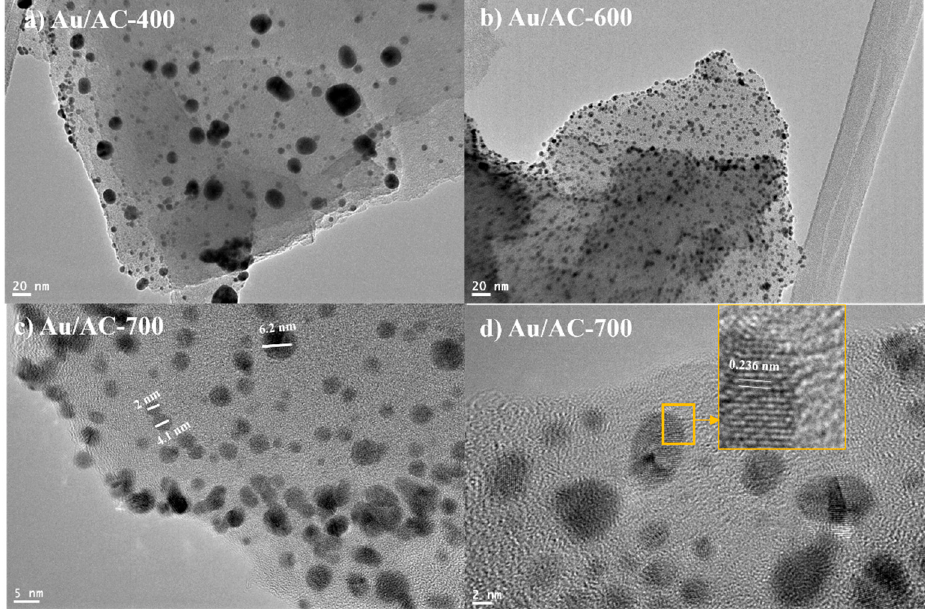
Figure 7. TEM images of Au/AC catalysts. ( a ) Au/AC-400, ( b ) Au/AC-600, ( c ) high-magnification image showing size of gold nanoparticles, ( d ) HRTEM image of gold nanoparticle shown in inset.